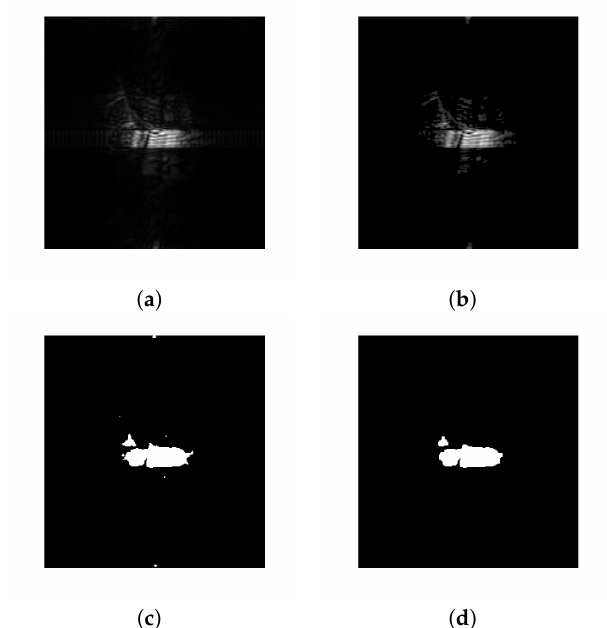
Figure 11. Illustration of the image processing chain on a concealed gun, ‘H’ polarization, 96 GHz: ( a ) grey level, ( b ) enhanced, ( c ) binarized, ( d ) mathematical